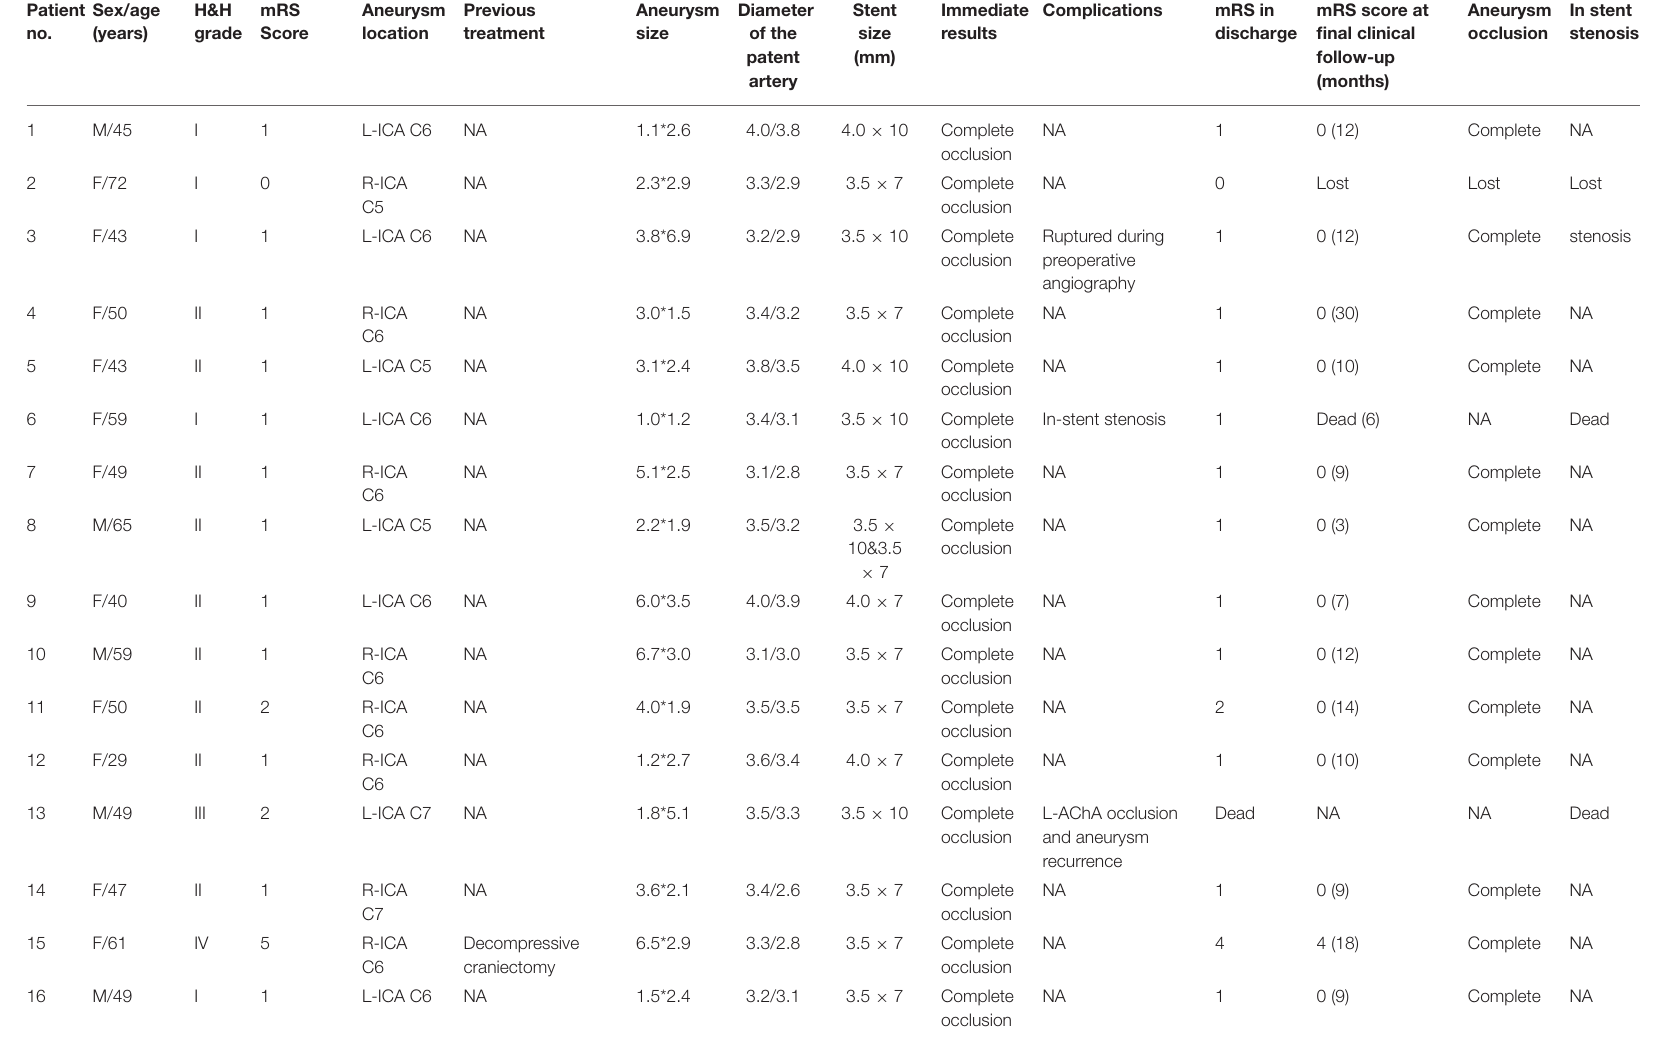
TABLE 1 | Demographic, clinical, CT data, endovascular treatment, and follow-up outcomes of the 16 patients. Patient